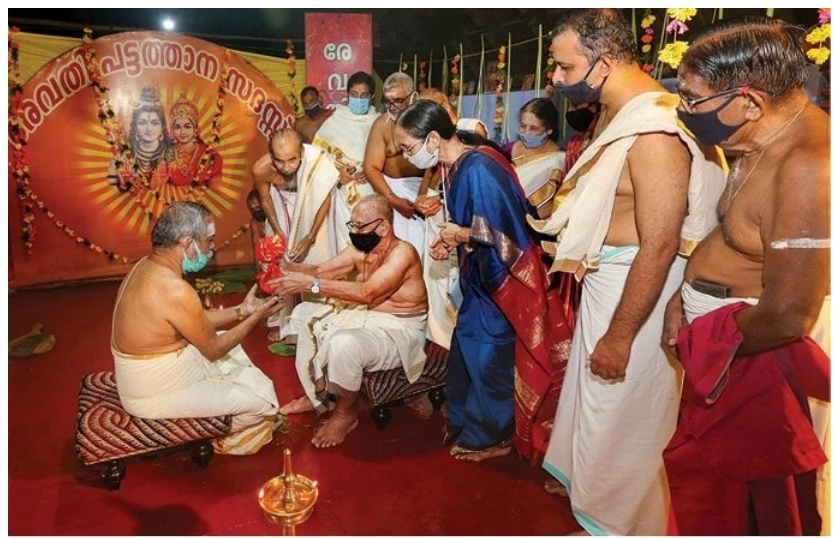
Figure 2. A Vedic scholar receives an award from the Zamorin of Calicut at the R ē vati pa ṭṭ att ā na ṁ (2020). Photo by G. Sudev Sharman.